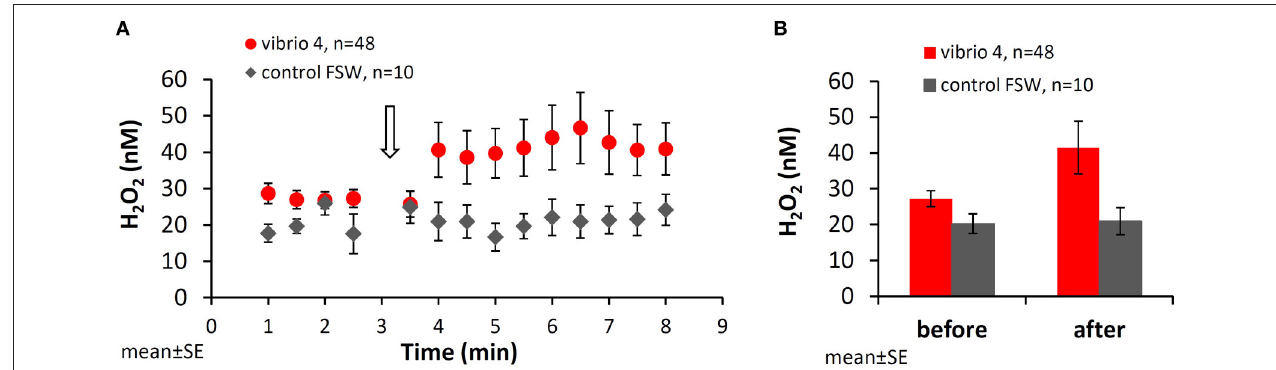
FIGURE 1 | Changes in H 2 O 2 concentrations in the vicinity of Stylophora pistillata following interaction with Vibrio . (A) H 2 O 2 concentrations next to the coral surface prior to and following addition of bacteria (10 5 cells of Vibrio 4 ; red dots) or filtered seawater as a control (gray diamonds). Vibrio 4 culture, originally isolated from healthy S. pistillata, was added after 3 min (open arrow) and the coral response was examined for additional 5 min. (B) Mean H 2 O 2 concentrations measured before (between 1.0 and 2.5 min) and after (between 3.5 and 8.0 min) interaction with Vibrio 4. All the data is averaged over the entire set of 48 experiments.